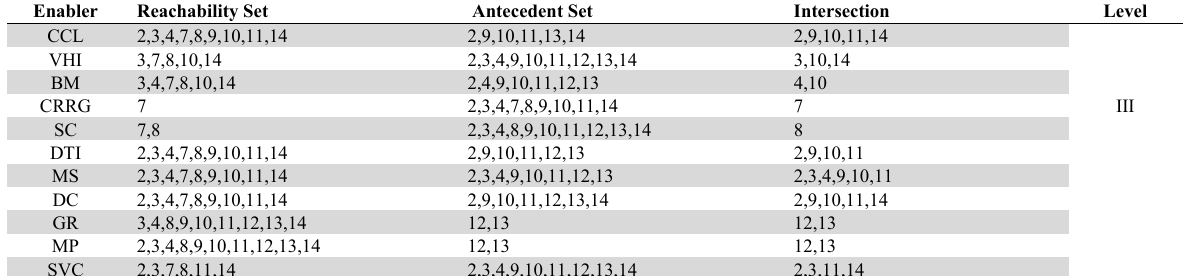
Level partitioning Iteration 3